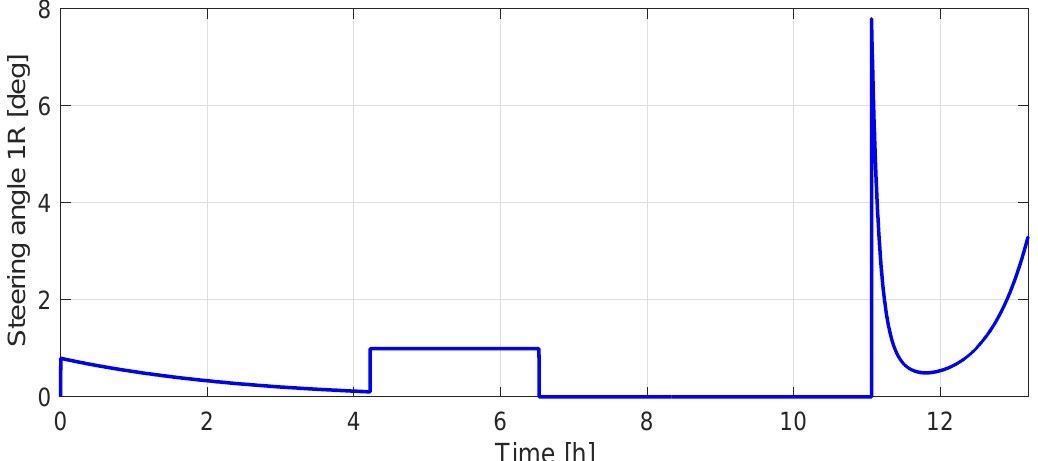
Figure 12. Steering angle of wheel 1R. Its time evolution points out the adopted steering strategies.